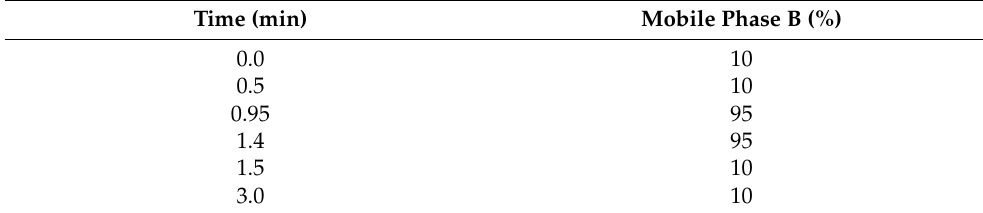
Table 4. The LC gradient elution for the separation of SN-38. Time (min) Mobile Phase B (%)